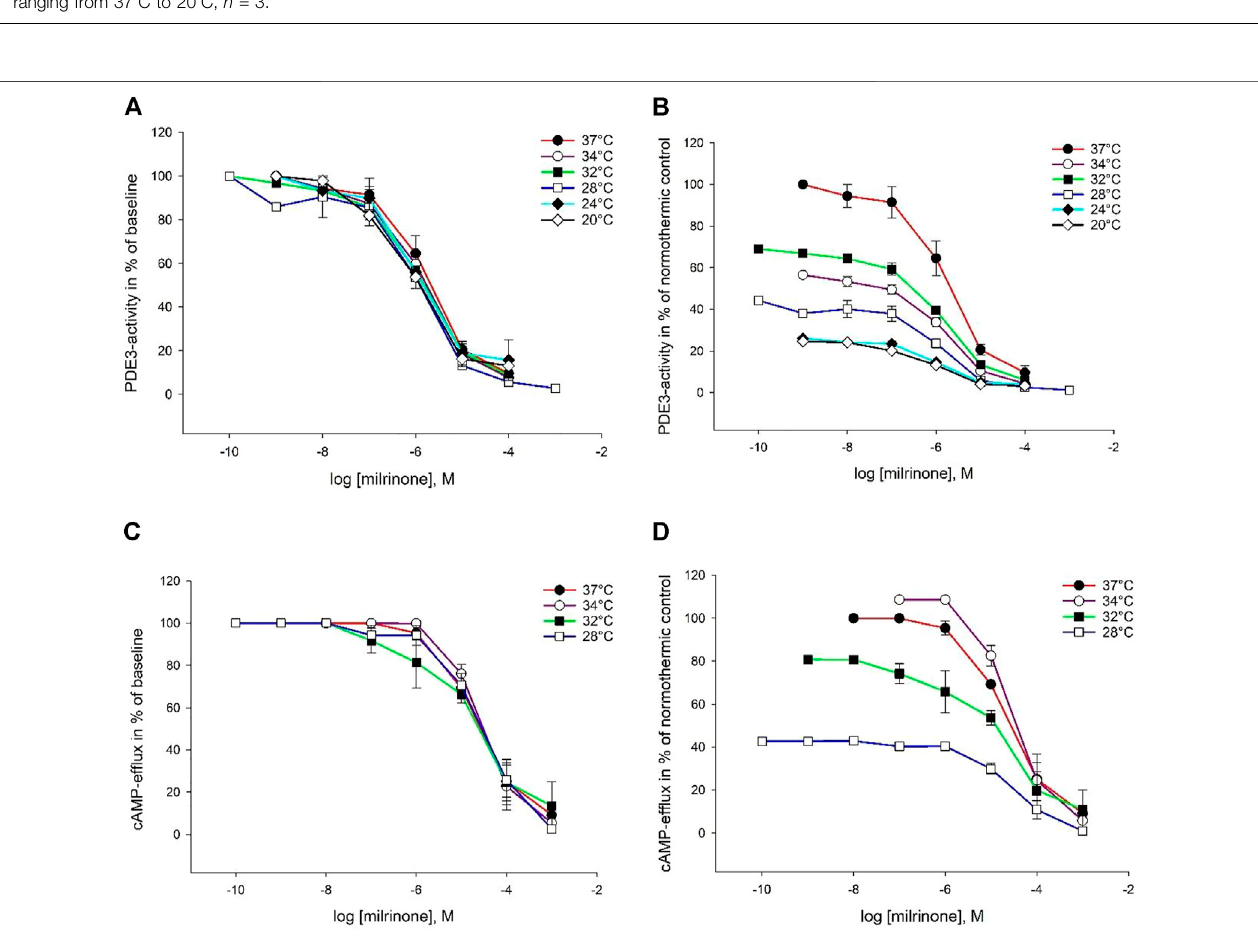
FIGURE 2 | Temperature-dependent inhibition of PDE3 and cAMP-ef fl ux by milrinone. The doses are in logarithm of the concentration in mol/L, presented as means ± SEM. (A) Inhibition curves for PDE3-activity at temperatures ranging from 37 ° C to 20 ° C. (B) Inhibition curves for PDE3-activity in % of normothermic inhibition curve at temperatures ranging from 37 ° C to 20 ° C. (C) Inhibition curves for ABCC4-activity at temperatures ranging from 37 ° C to 20 ° C. (D) Inhibition curves for ABCC4- activity in % of normothermic inhibition curve at temperatures ranging from 37 ° C to 20 ° C.